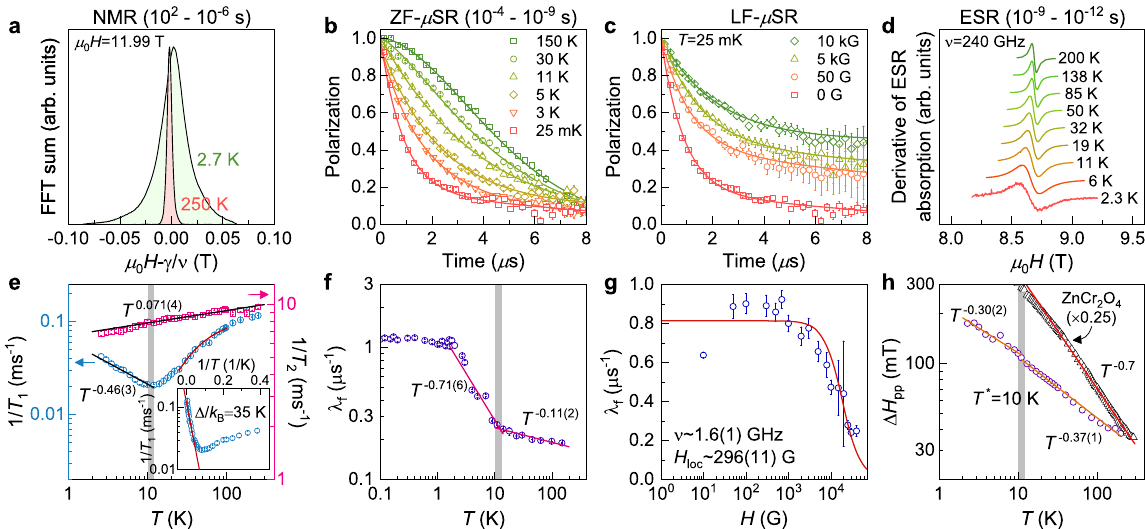
Fig. 3 Thermal and temporal evolution of spin fl uctuations of LiGa 0.2 In 0.8 Cr 4 O 8 measured by 7 Li NMR, ZF- μ SR, and ESR. a 7 Li NMR spectra at selected temperatures T = 2.7 and 250 K. b ZF- μ SR spectra at selected temperatures. c Longitudinal- fi eld dependence of the μ SR spectra measured at T = 25 mK. The solid lines denote the fi t to the data using the sum of two simple exponential functions. d Derivative of the ESR absorption spectra measured at various temperatures. Spectra are vertically shifted for clarity. e T dependence of 7 Li spin-lattice relaxation rate 1/ T 1 and spin-spin relaxation rate 1/ T 2 . The red solid line denotes the Arrhenius equation, yielding the spin pseudogap of Δ / k B = 35(1) K. The solid black line represents a power-law behavior of 1/ T 1 and 1/ T 2 . f Muon spin relaxation rate as a function of temperature λ f ( T ). The solid magenta line represents the power-law fi t to the data. g Muon spin relaxation as a function of longitudinal fi eld λ LF ( H ), along with fi tting to the Red fi eld formula. h T dependence of the peak-to-peak ESR linewidth Δ H pp ( T ). The solid orange lines indicate a power-law behavior of Δ H pp ( T ) in two different temperature ranges marked by the shaded region at T * = 10 K. Error bars on the data points indicate a standard error.